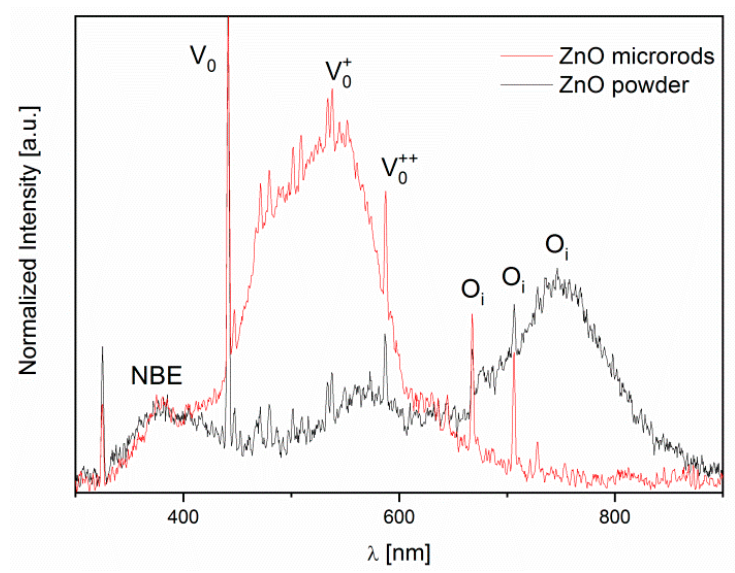
Figure 7. Photoluminescence (PL) spectra of ZnO samples.